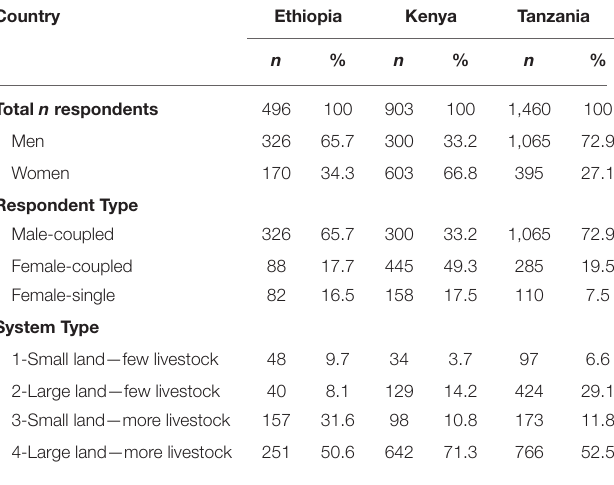
TABLE 2 | Sample structure by respondent gender, household type and system type by country.